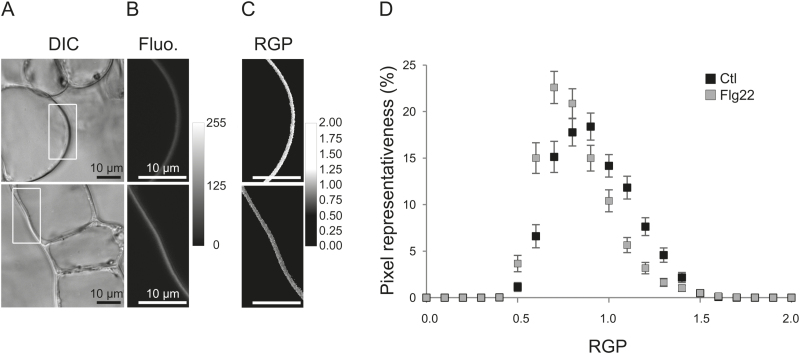
Increase of the representativeness of PM ordered domains by flg22 in Arabidopsis thaliana cells. Arabidopsis cells were observed after elicitation treatment with 20nM flg22 (bottom) or in control conditions (top). (A) Differential interference contrast (DIC) microscopy images. (B) Fluorescence (Fluo.) of plasma membrane of di-4-ANEPPDHQ-labelled Arabidopsis cells (excitation at 488nm; emission corresponds to the sum of fluorescence intensities acquired from channels ranging from 520nm to 680nm) with a grey scale rendering of fluorescence intensity. (C) Ratiometric images of di-4-ANEPPDHQ- (3 µM) labelled Arabidopsis cells were pseudocolour-coded, according to the accompanying RGP value scale showing the membrane order. A zoom of an area extracted from the PM surface is displayed. Scale bar=10 µm. (D) Each pixel constituting the analysed PM surface was associated with its own level of order (RGP) and a comparison of the distribution of the membrane order between flagellin-treated (Flg22, grey squares) and control cells (Ctl, black squares) is given. The x-axis represents the class of order level values. The y-axis represents the percentage of each class of pixel values. Data are means ±SE of the mean (n=206 cells, from four independent experiments).